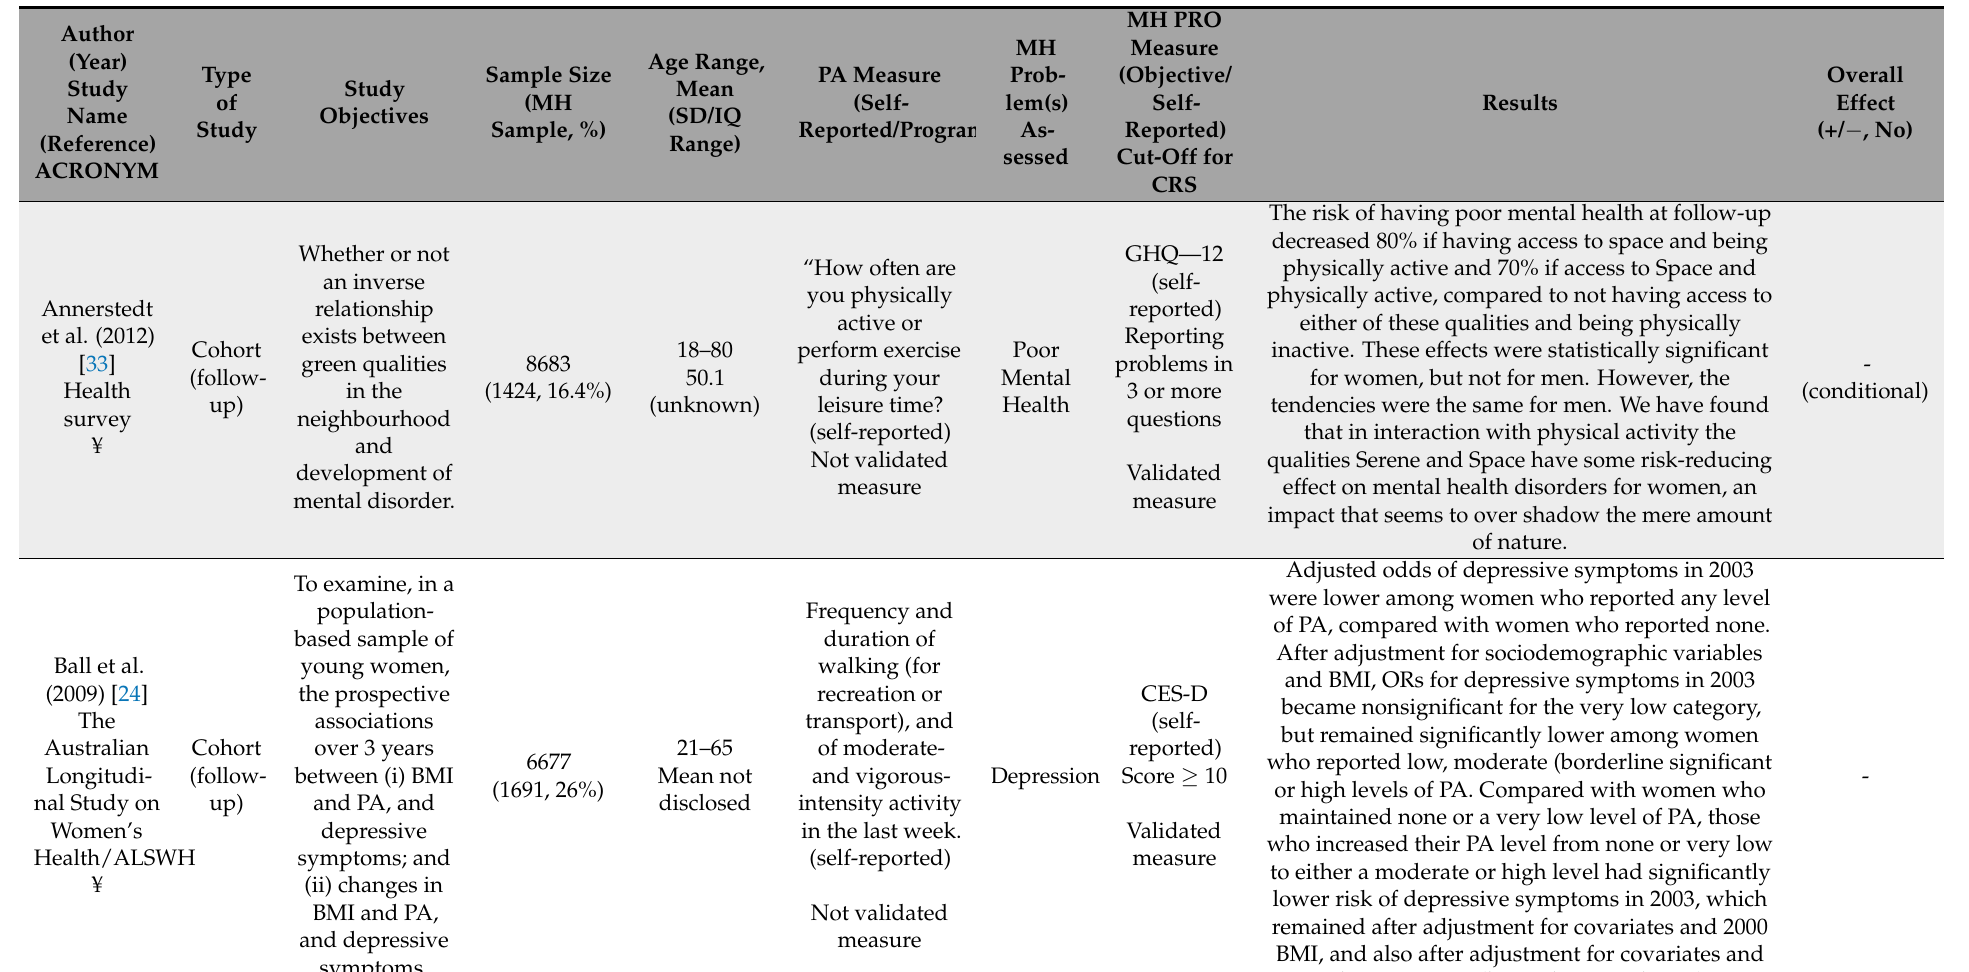
Table 1. Characteristics and summary findings of the included